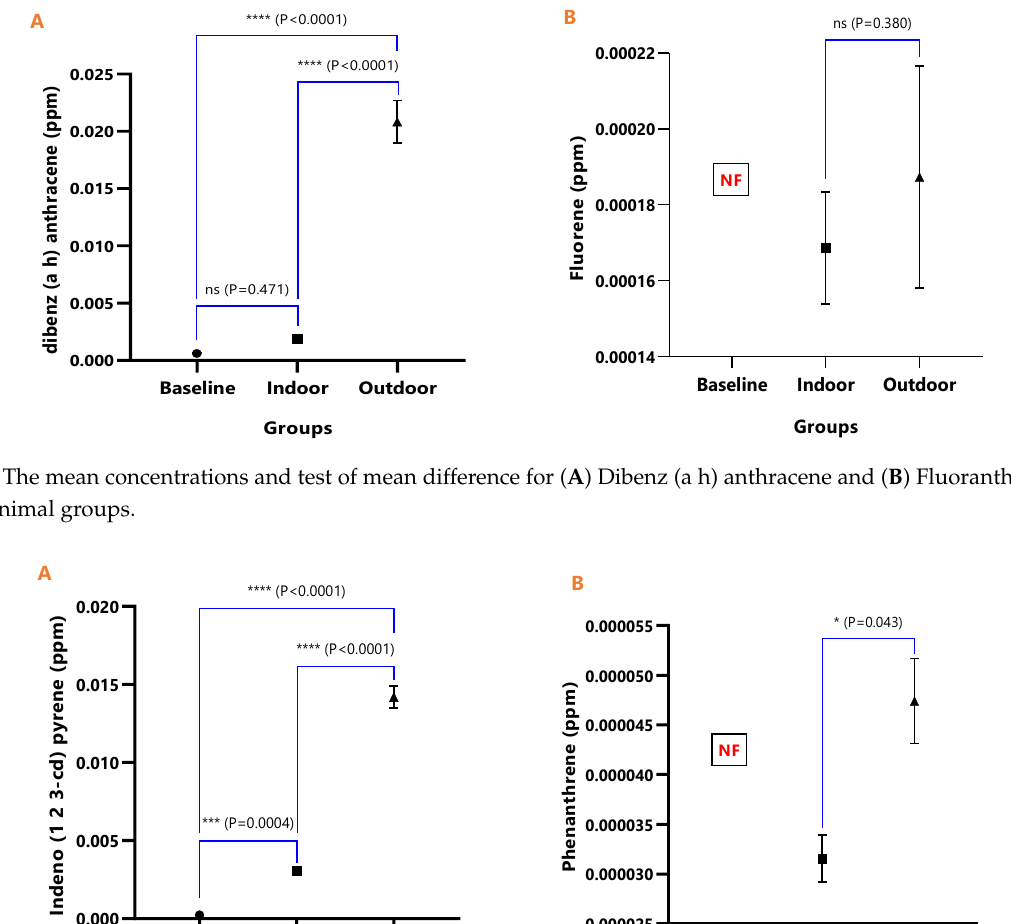
Figure 7. The mean concentrations and test of mean difference for ( A ) Benzo (k) fluoranthene and ( B ) Chrysene in the various animal groups.